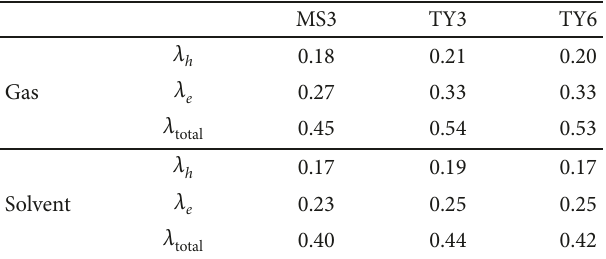
Table 9: Reorganization energy of MS3, TY3, and TY6 in gas and solvent